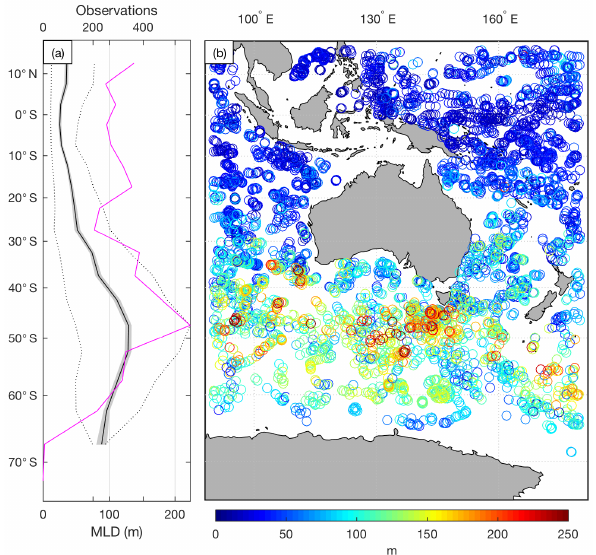
Figure 2. (a) The zonal mean of the observed MLD (metres) derived from Class 4 Argo profiles over the study period; 90% confidence intervals are shaded and the 5th and 95th percentiles are shown by the dotted lines. The number of profiles in each 5 ◦ bin is also indi- cated by the magenta line. (b) The individual MLD